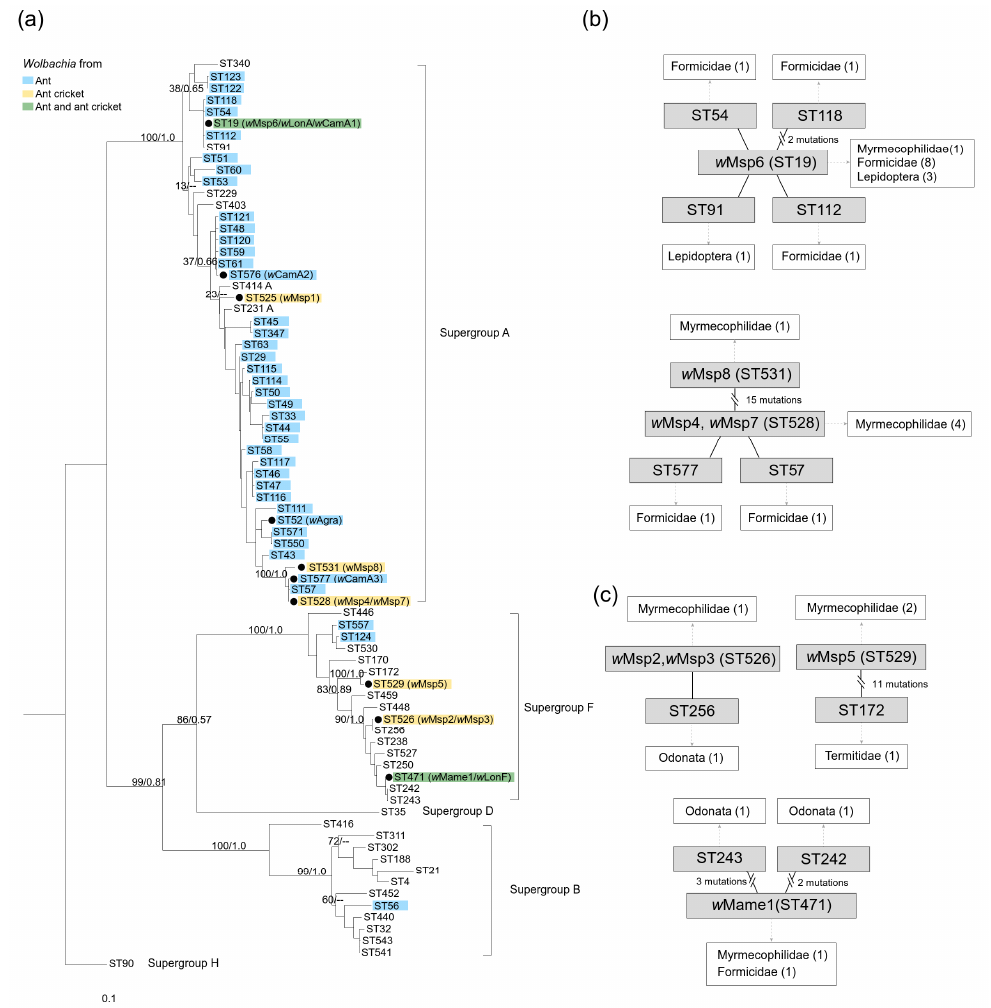
Figure 2. ( a ) Maximum Likelihood (ML) phylogeny of Wolbachia based on MLST data, with ML bootstrap values (left) and Bayesian posterior probability (right) given. Note that both Bayesian inference and ML yielded a highly similar topology. Black circles denote the Wolbachia STs identified in the present study. Wolbachia from ants, ant crickets and Wolbachia shared between ants and ant crickets are colored blue, yellow and green, respectively. Relationships among supergroup A Wolbachia and supergroup F Wolbachia strains based on MLST data are shown in ( b , c ), respectively. Strains that differ in a single mutation are connected with a solid line. Host information is provided in the white box with the number of host species indicated in parentheses.